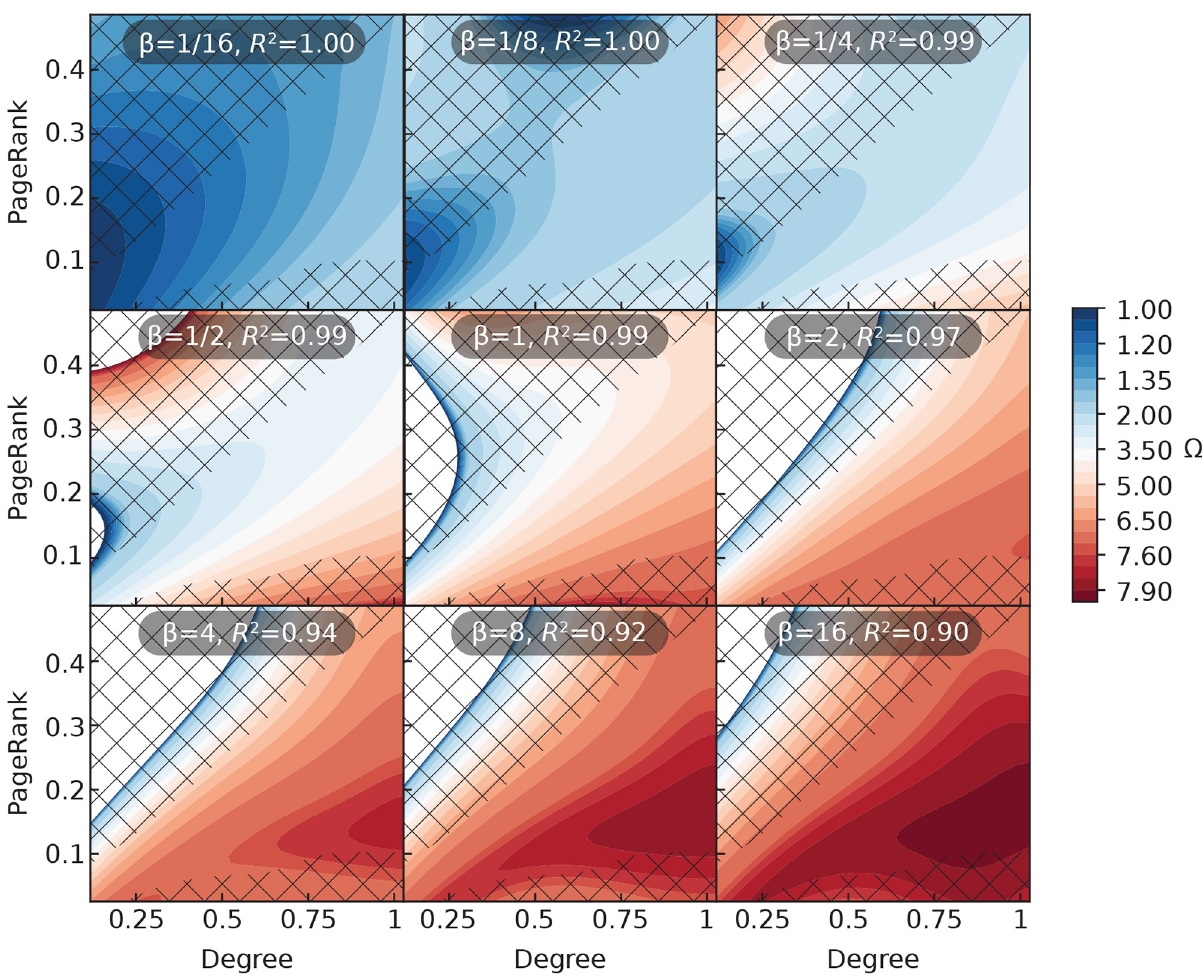
Fig 13. Prediction maps for the combination of degree and PageRank at different transmission rates. In each of these subpanels for nine infection rates β , the degree centrality is given on the x-axis and PageRank on the y-axis. The diagonal grid shows regions where no real graph exists. N = 8 for all